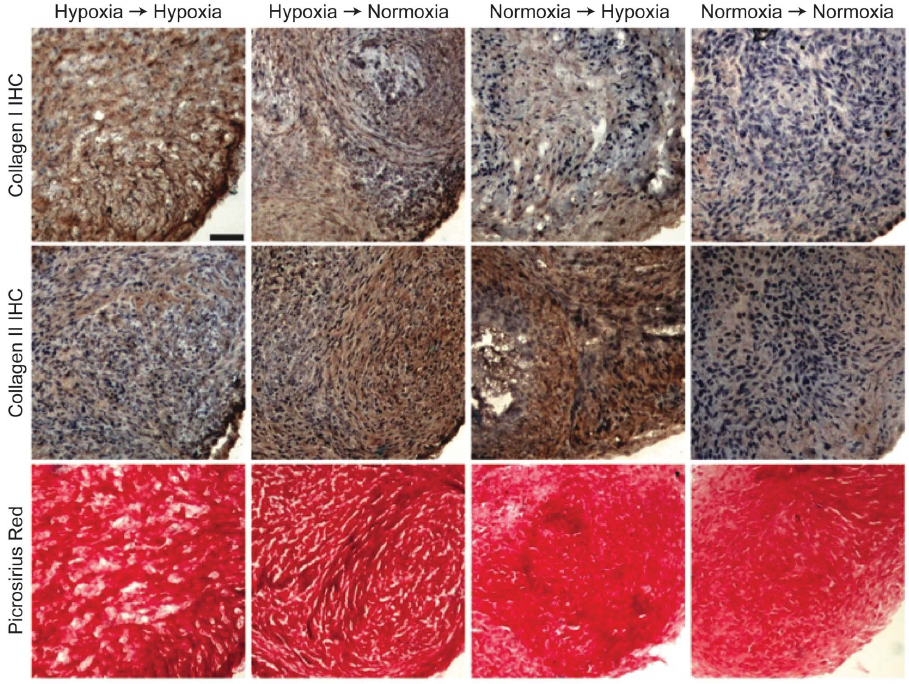
Figure 5. Histological sections of micromasses after 2 weeks. Collagen type I staining was strongest for HH (first row), while collagen type II staining was strongest for NH (second row). All groups stained positive for collagen (third